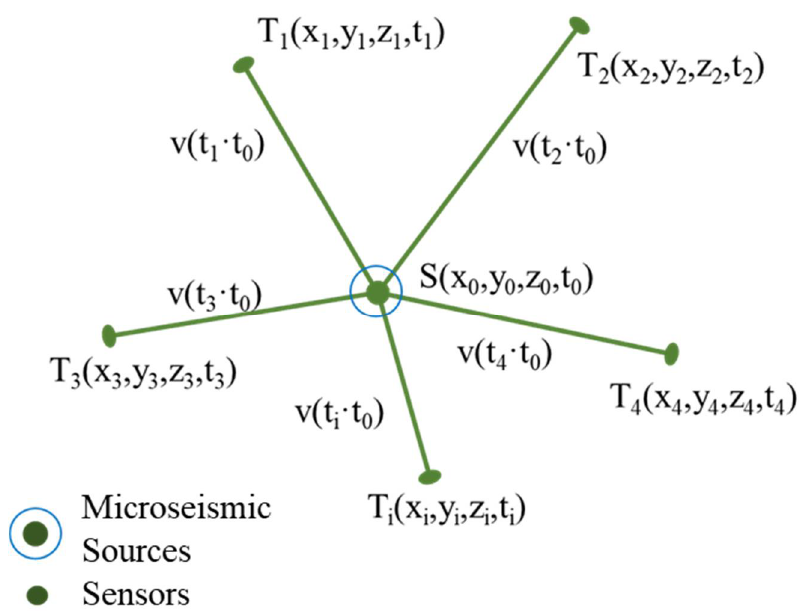
Figure 2. Principle of TDOA source location.